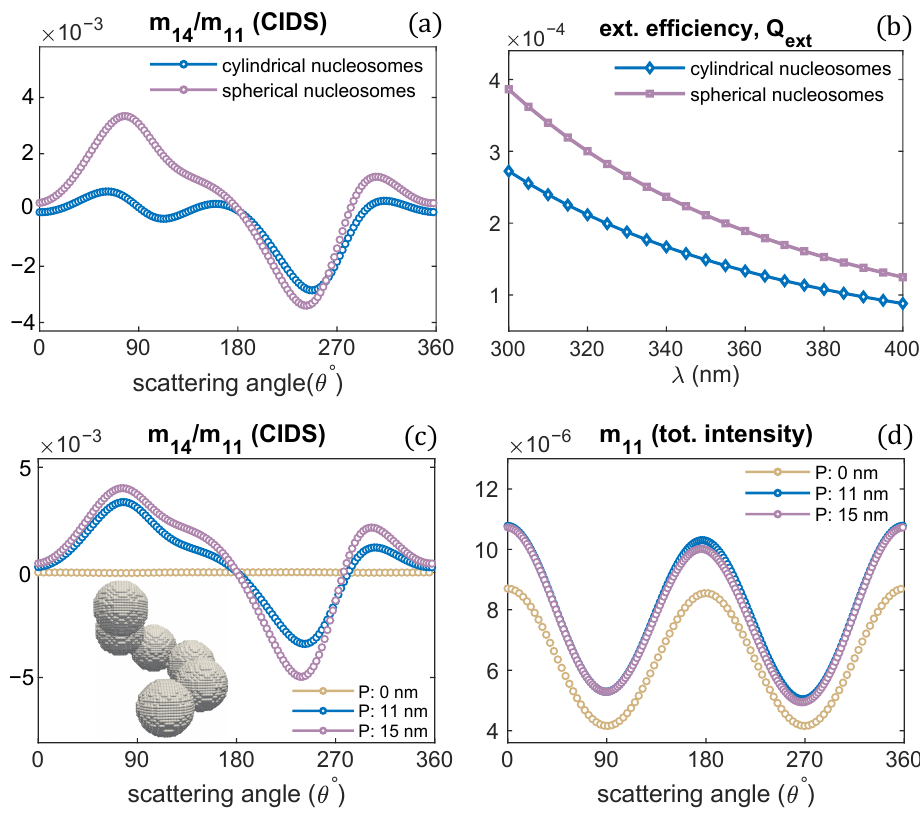
Figure 9. ( a , b ) CIDS and extinction efficiency for two different shaped nucleosomes, respectively; ( c , d ) scattering calculations for the chromatin fiber with spherical shaped nucleosomes, λ = 300